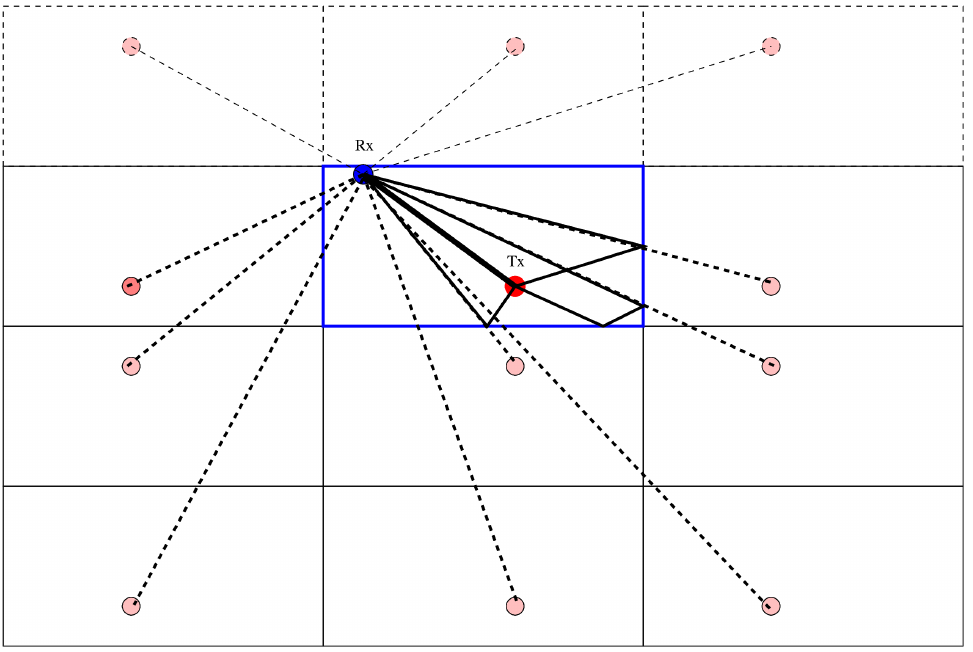
Figure 3. Schematic of multipath reflection